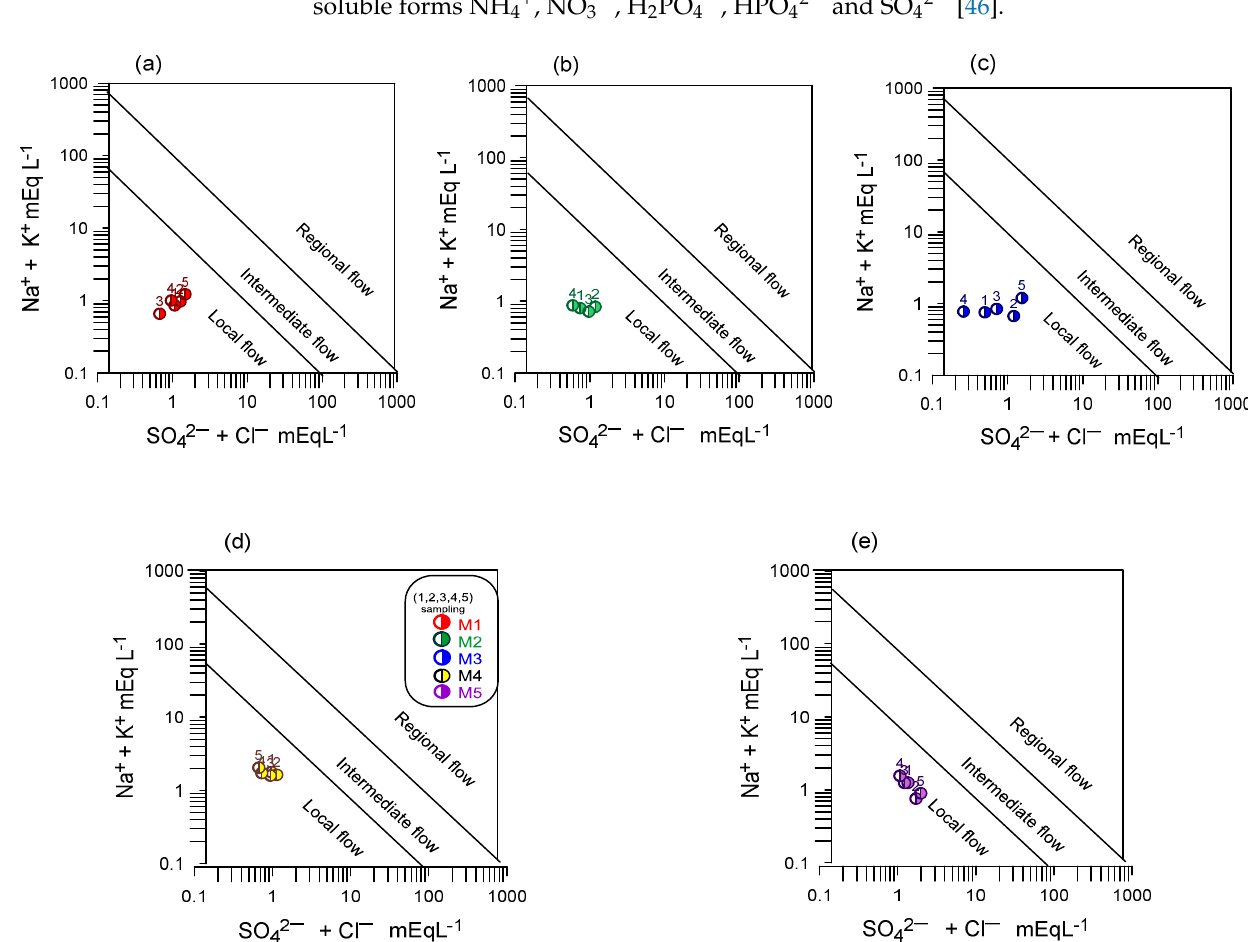
Int. J. Environ. Res. Public Health 2021 , 18 , x Figure 5. Mifflin diagram, classification of the water according to its evolution during all sampling periods: ( a ) Sample S1, ( b ) Sample S2, ( c ) Sample S3, ( d ) Sample S4, and ( e ) Sample S5.